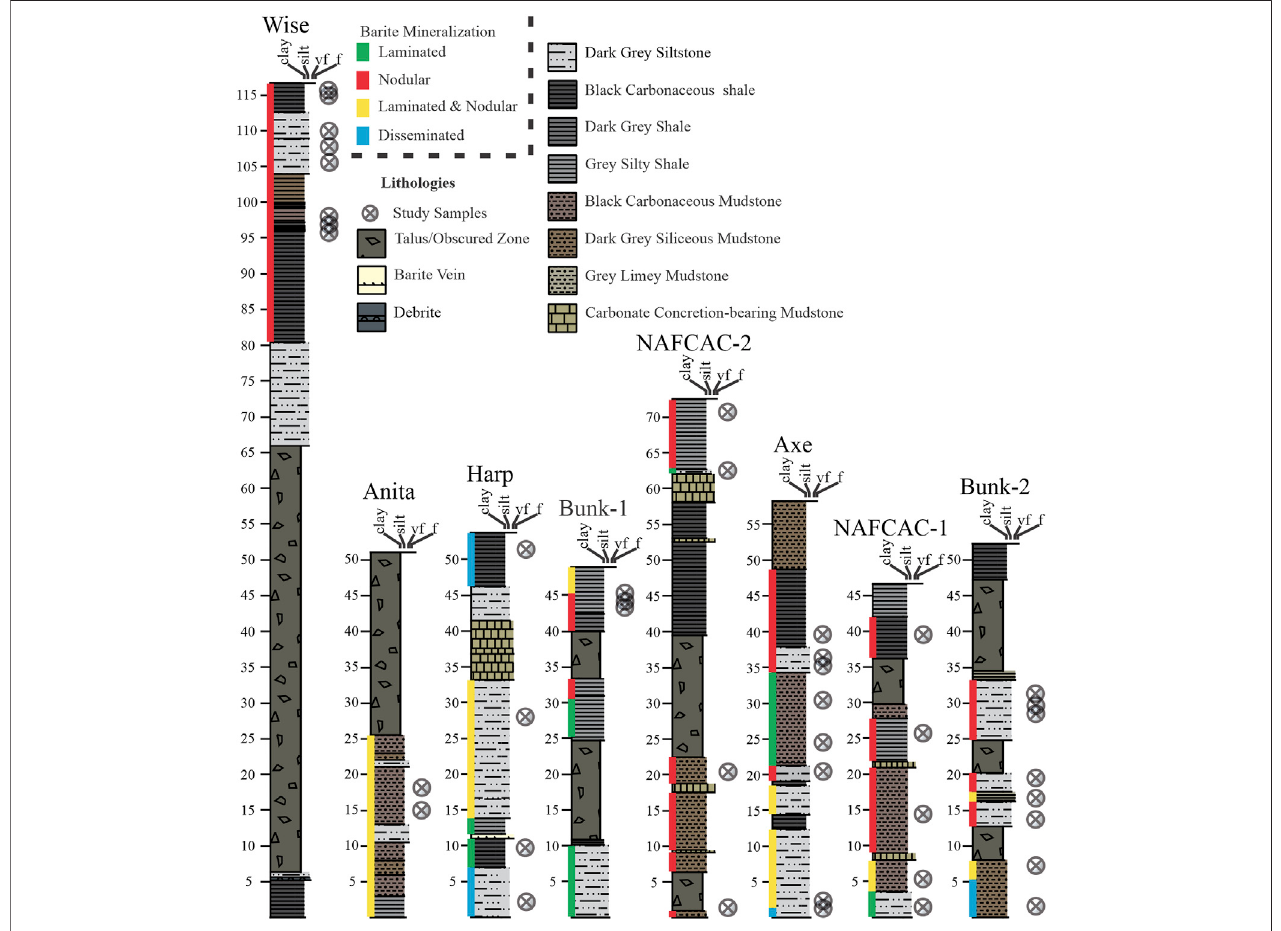
FIGURE 3 | Lithostratigraphic pro fi les of barite-bearing upper sections of the Canol Formation. (Modi fi ed from Fernandes et al., 2017).